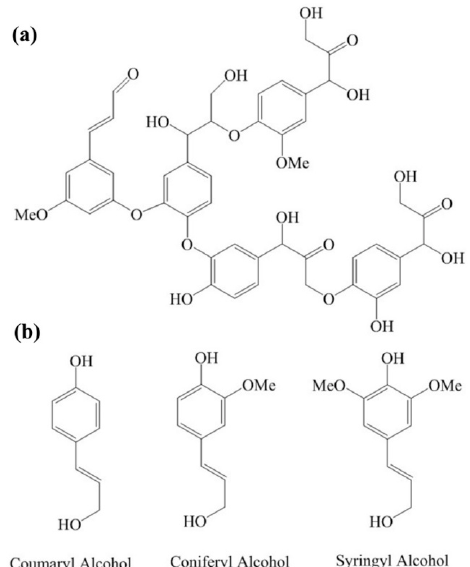
Figure 2. The chemical structure and composition of lignin. ( a ) Structural fragment of a lignin polymer. Lignin is a series of randomly cross-linked phenolic polymers. It has no specific chemical formulation, and this differs from species to species. ( b ) The chemical structures of three monomers of lignin: p -coumaryl alcohol, coniferyl alcohol, and sinapyl alcohol, respectively.